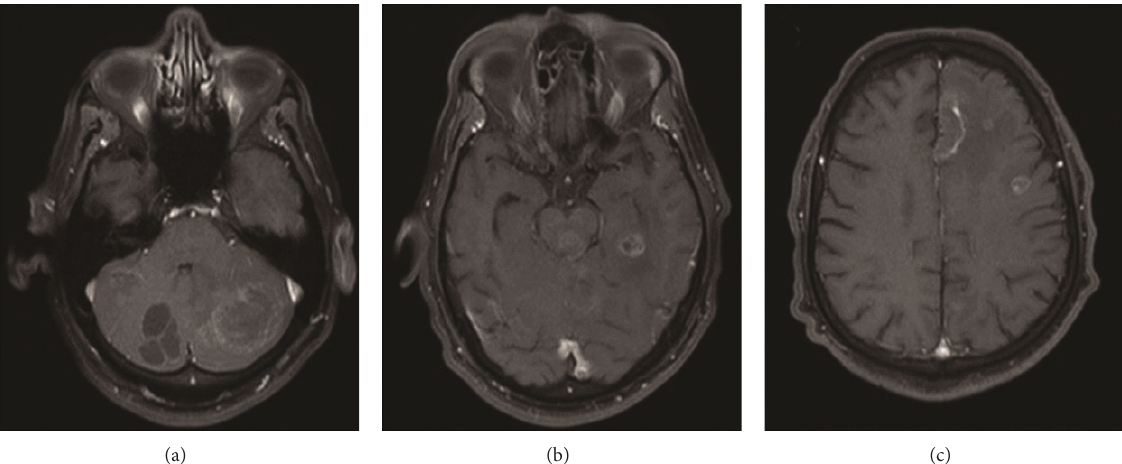
Figure 1: Some lesion with ring enhancement by means of contrast, sparsely in the left cerebral hemisphere, with peripheral and subcortical distribution, and also in the cerebellum.